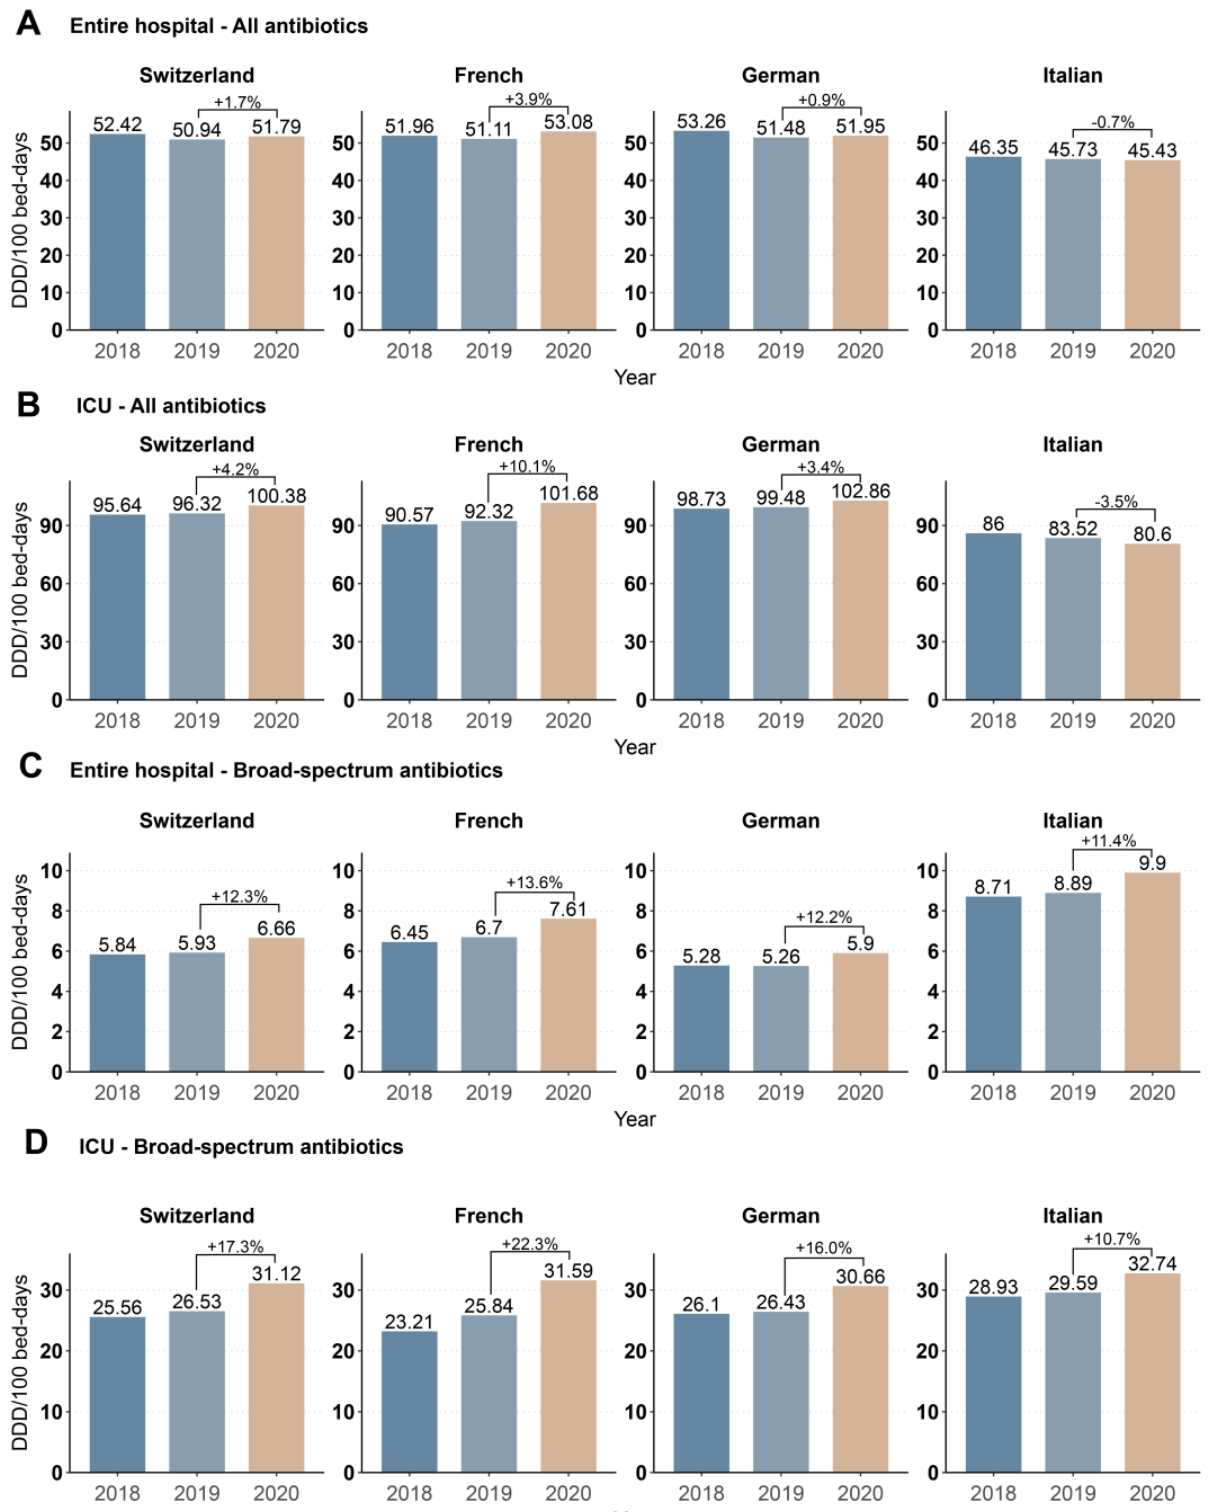
Figure 1. Antibiotic consumption in DDD/100 bed-days in Switzerland and the three linguistic regions from 2018–2020 for all antibiotics for systemic use (ATC code J01) in ( A ) the entire hospital and ( B ) ICUs and for broad spectrum antibiotics only, for ( C ) the entire hospital and ( D ) ICUs. Percentage changes between 2019 and 2020 are indicated.